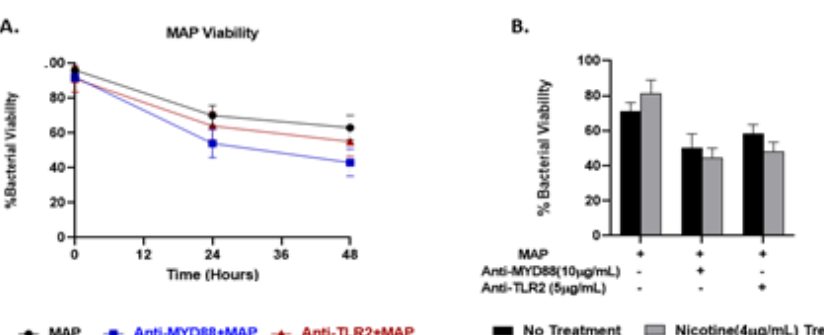
Figure 7. E ff ect of nicotine on MAP survival in macrophages blocked with TLR2 / MyD88 antagonists. MAP viability was measured in infected macrophages preincubated with 10 µ g / mL of T6167923 or 5 µ g / mL of MMG11 after 48 hours without nicotine ( A ) and with nicotine treatment ( B ). All experiments were performed in duplicates. ( + ): Presence, ( - ): Absence.